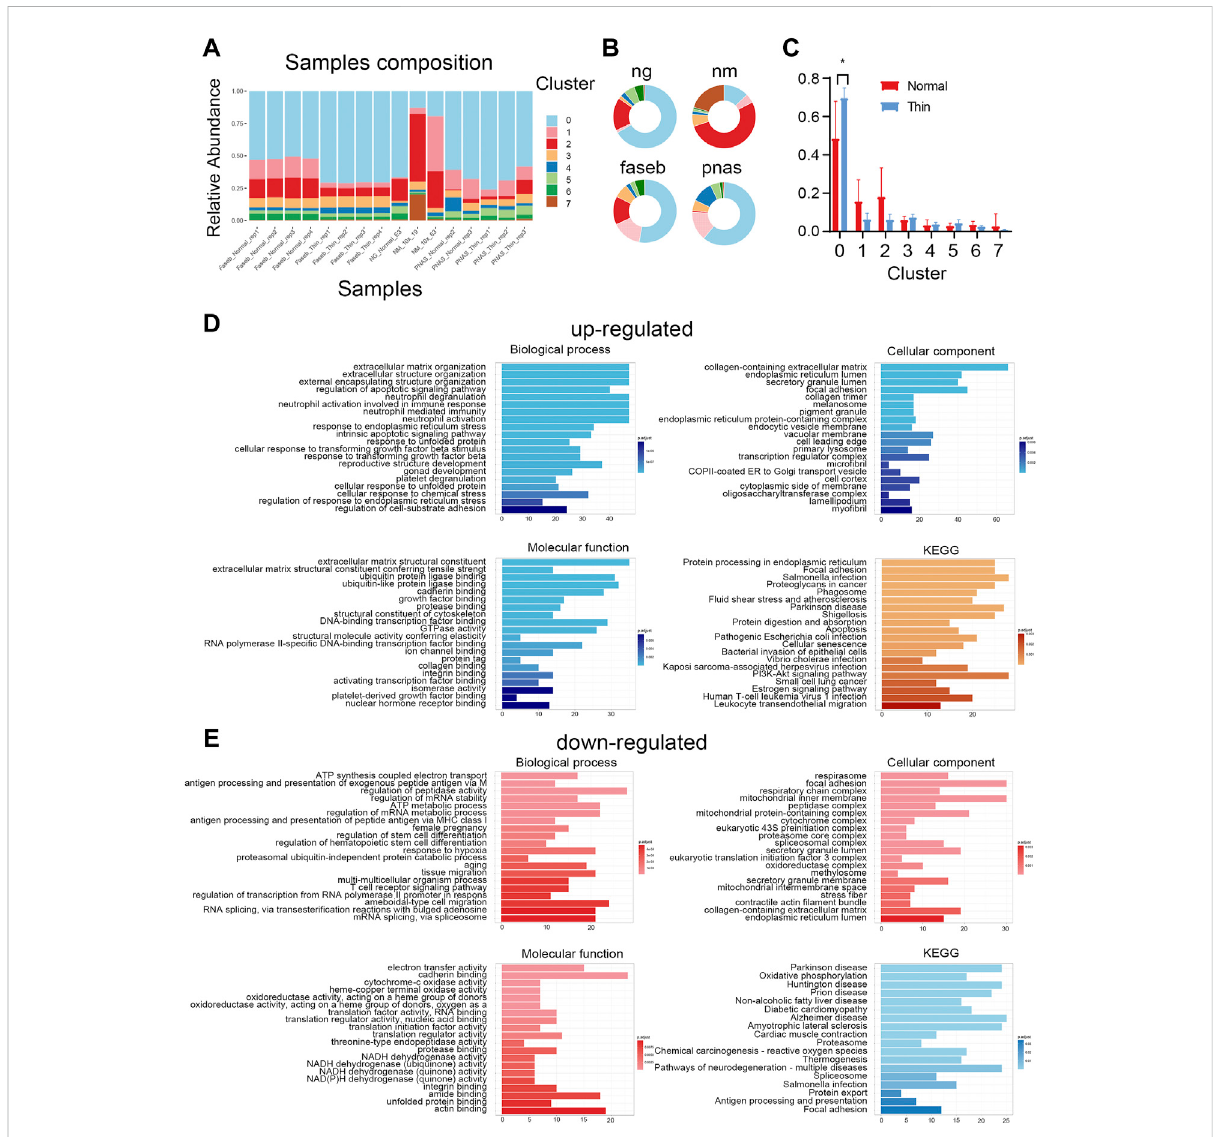
FIGURE 2 Differential cell population in thin endometrial tissue. (A) The cell type composition for each sample. (B) The sample pro fi les in individual projects. (C) The proportions of cell types in normal and thin endometrial tissues. * p < 0.05. The functional annotation for the upregulated (D) and downregulated (E) DEGs in stromal